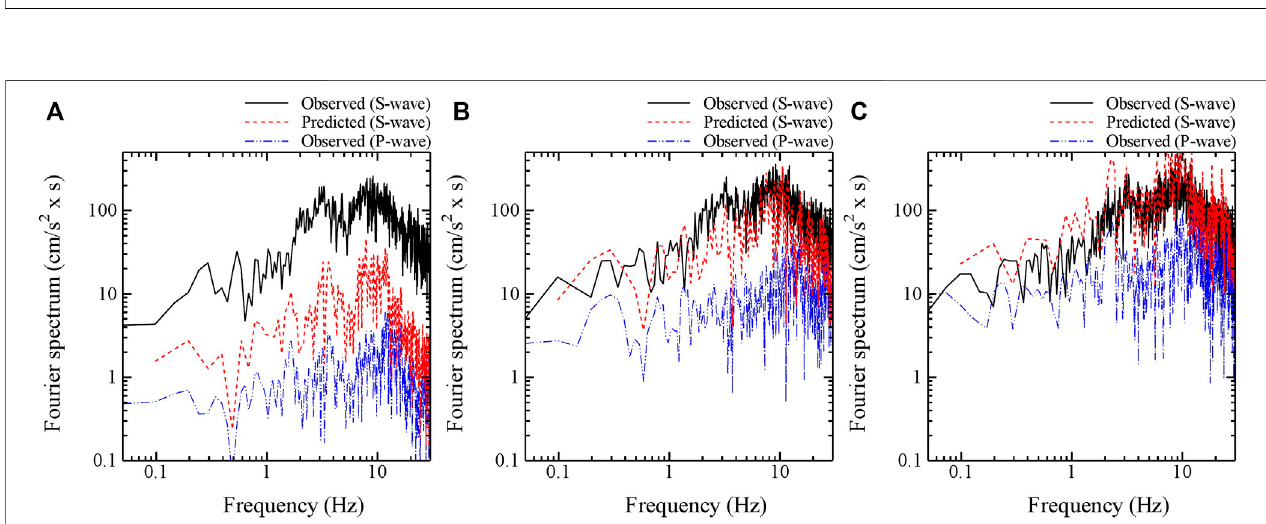
FIGURE12 | Predicted Fourierspectraof S-wave for time-windowsof10,20, and 25 s during the 2011off the Paci fi ccoast ofTohoku earthquake ( Mw 9.0) at KS station. (A) Time-window of 10 s (B) Time-window of 20 s (C) Time-window of 25 s.